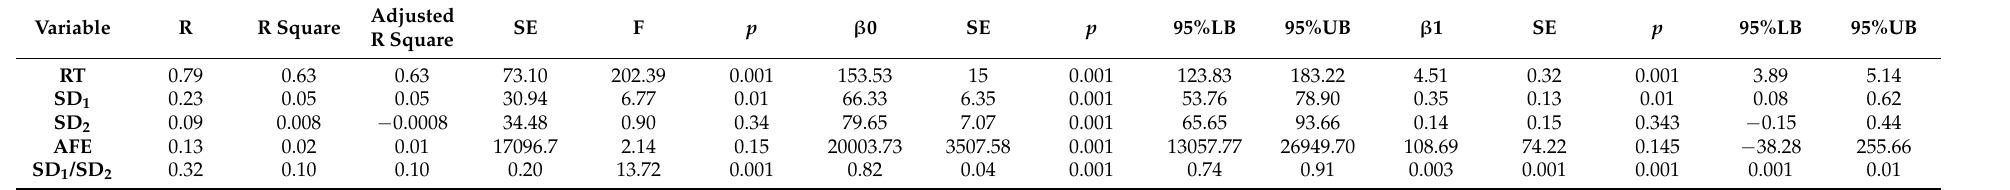
Table 5. Results of the simple linear regression analysis for the effect of age on Poincar é parameters ( n = 120).